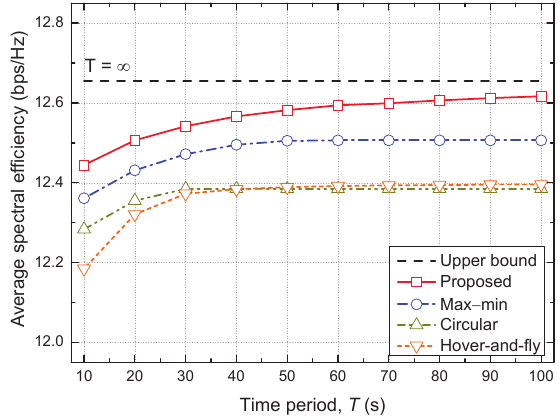
Figure 5. Average spectral efficiency vs. time period.